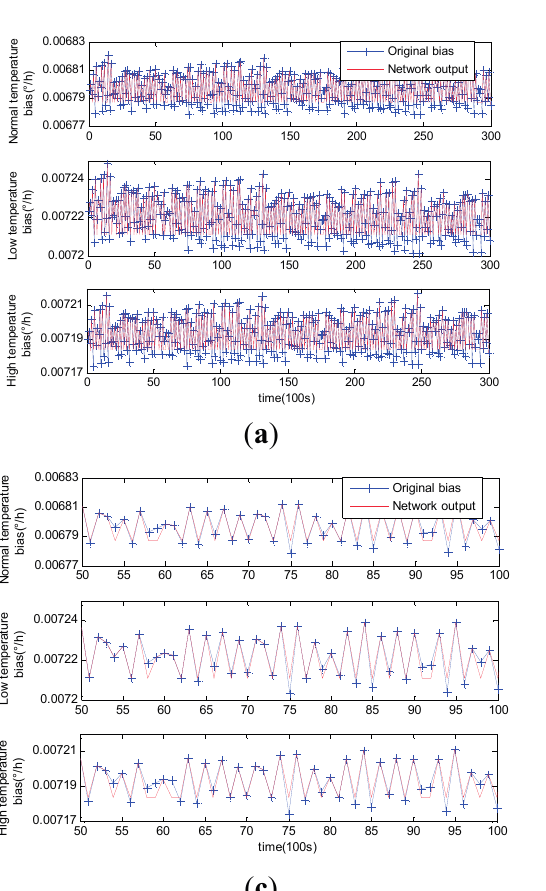
Figure 7. Identification curves using traditional RBFNN: ( a ) constant temperature; ( b ) variable temperature; ( c ) enlarged (a) in the horizontal axis from 50 to 100; ( d ) enlarged (b) in the horizontal axis from 50 to